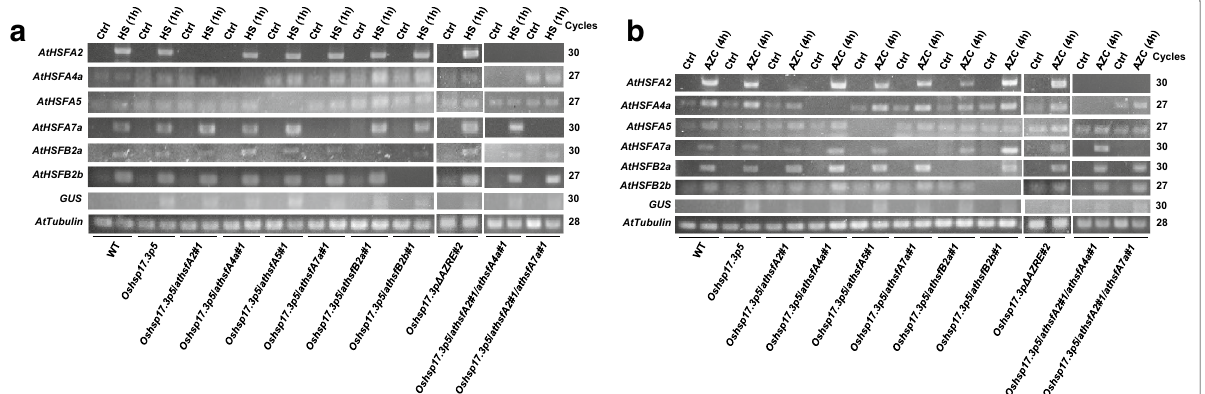
Fig. 3 Expression profiles of AtHSFs in AtHSF mutants with HS and AZC treatment. RT‑PCR analysis of transcript levels in the AtHSF ‑knockout mutant seedlings treated with a HS and b AZC for the indicated times. AtTubulin level was an internal control. Two biological repeats were performed, and similar results were obtained. Non‑stress control condition